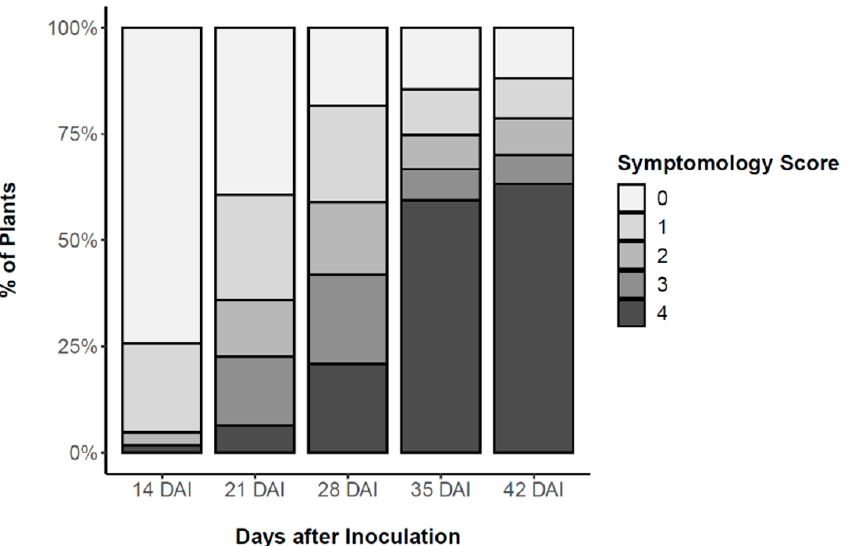
Figure 1. Weekly pine wilt disease (PWD) progression in Pinus pinaster half-sib plants after inoculation with the pinewood nematode (PWN) Bursaphelenchus xylophilus , according to a five-level symptomology score based on the % of needles being yellow or brown; namely, 0 (0%), 1 (1–25%), 2 (26–50%), 3 (51–75%), and 4 (76–100%). The validated LC-QqQ-MS/MS method was applied to study changes in the absolute levels of phytohormones in stem tissues of 2-year-old P. pinaster plants, with contrasting responses to PWN infection. Five phytohormones were quantified in stem tissues of P. pinaster , namely ABA, GA, JA-ME, SA, and ZeaR, 24, 48 and 72 h after inoculation (HAI) (Figure 2, Table A1). ABA significantly decreased in resistant inoculated plants at 48 HAI, when compared to susceptible plants (Figure 2A). JA-ME showed a significant increase in susceptible plants at 72 HAI, when compared to all other treatments (non-inoculated, mock-inoculated and resistant-inoculated plants) (Figure 2C). SA showed a significant increase in susceptible plants at 48 HAI, when compared to the remaining treatments, and also a significant increase at 72 HAI, in relation to resistant plants (Figure 2D). GA and ZeaR showed no significant variation in inoculated P. pinaster stem tissues, among treatments for all time points (Figure 2B,E). The remaining nine phytohormones (BA, GA 9 , IAA, IAA-ME, IBA, IBA-ME, JA, iP, Zea) were detected in levels below the LOQ, and therefore were not